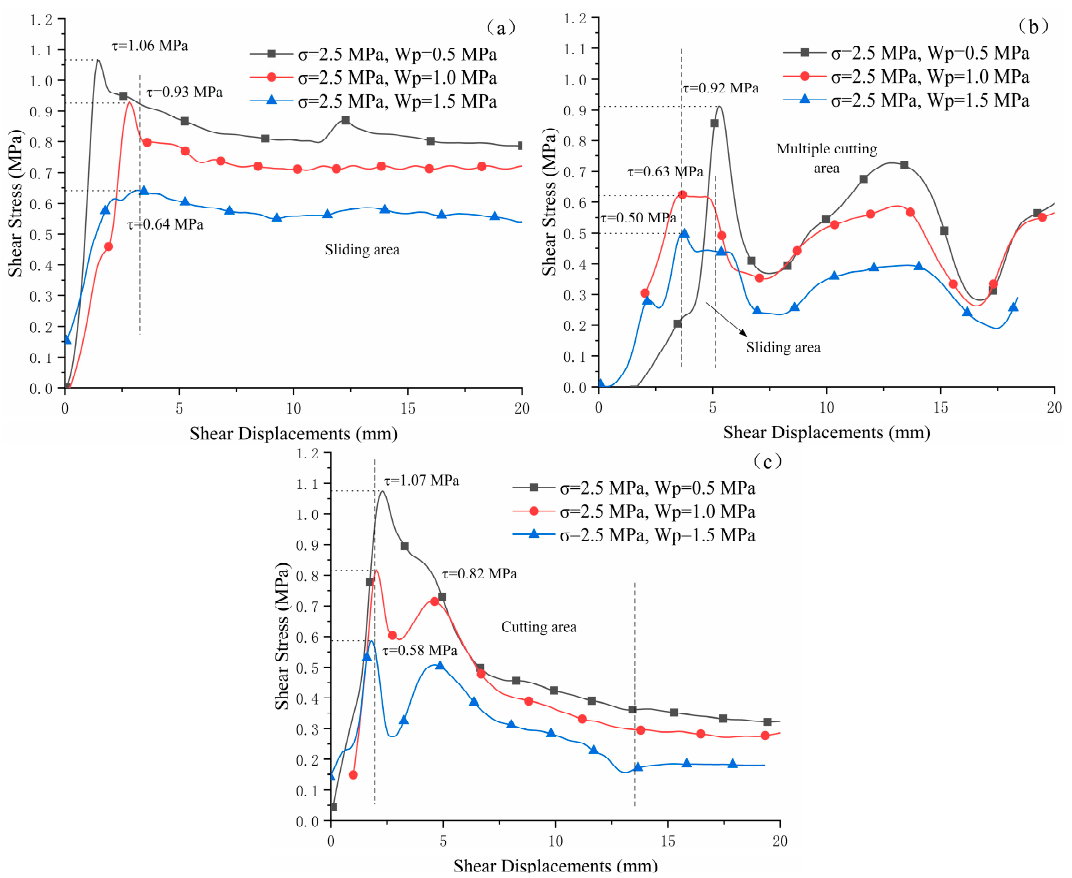
Figure 6. Shear deformation curves of joint surfaces under different seepage pressures when normal stress is 2.5 MPa: ( a ) joint roughness is 0°; ( b ) joint roughness is 15°; ( c ) joint roughness is 30°.